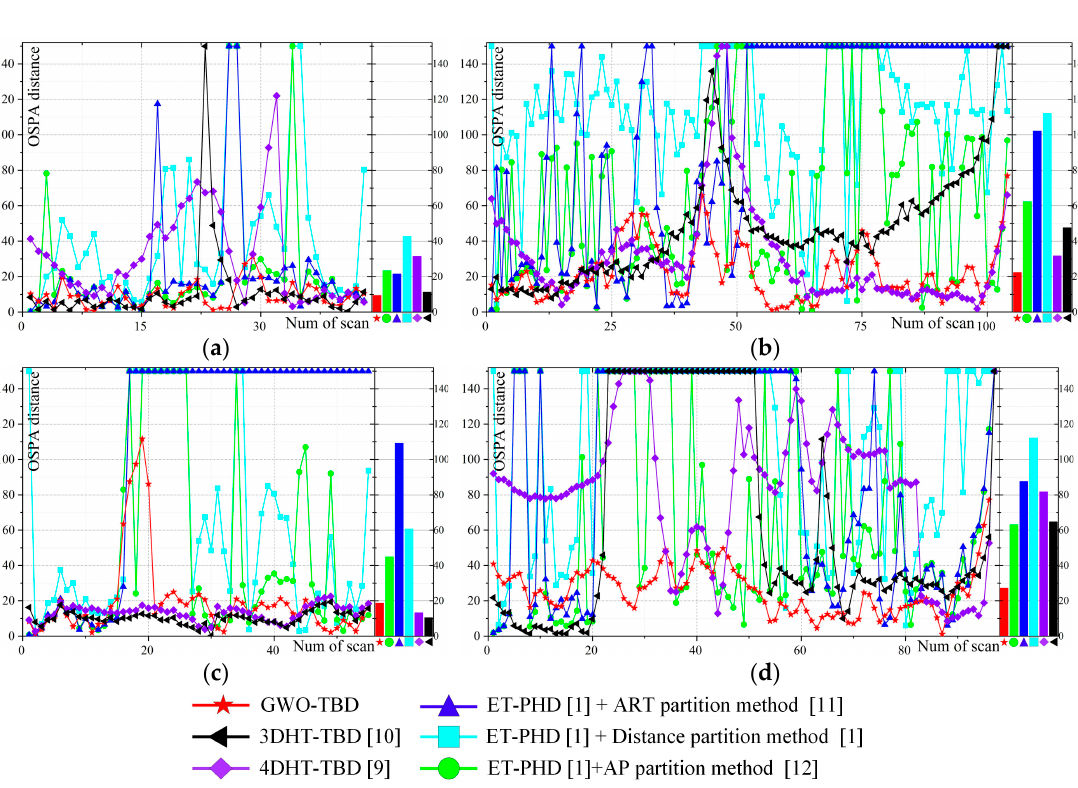
Figure 9. The OSPA distance of the four real scenarios. ( a )–( d ) correspond to real scenarios 1–4.